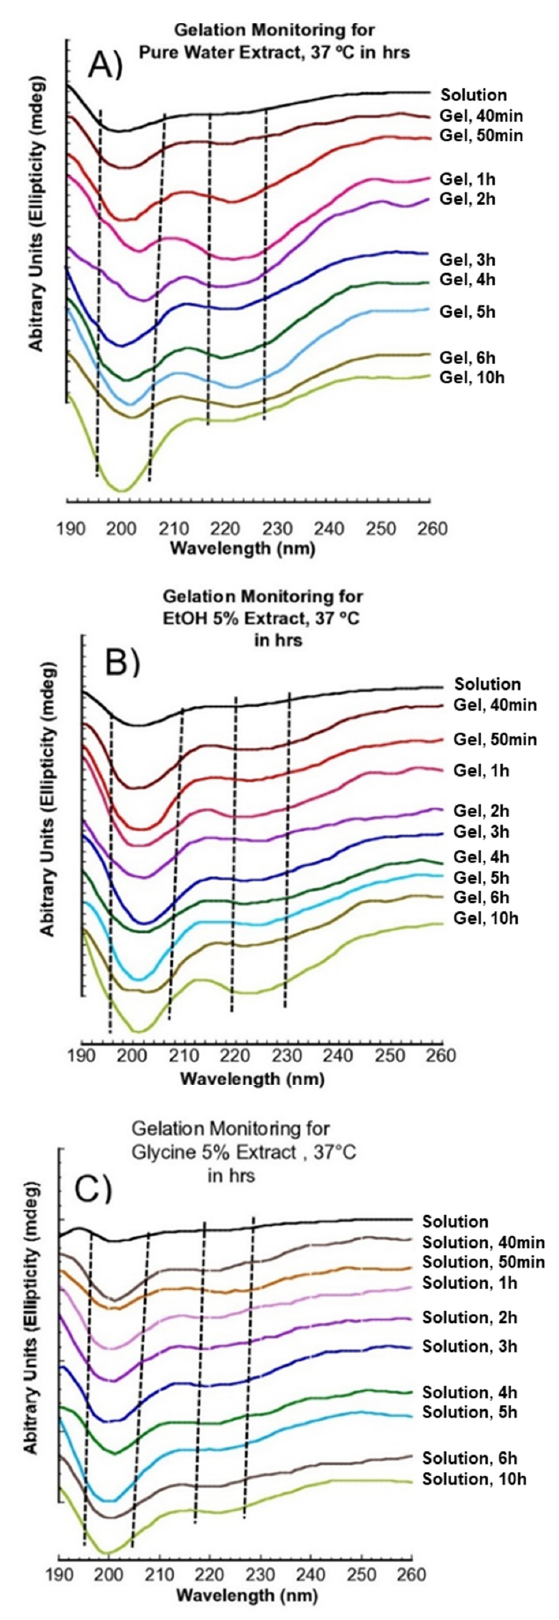
Figure 5. CD spectra of SS with time. ( A ) Gelation of water extract at 37 °C; ( B ) gelation of EtOH 5% at 37 °C; ( C ) gelation at glycine 5% at 37 °C .